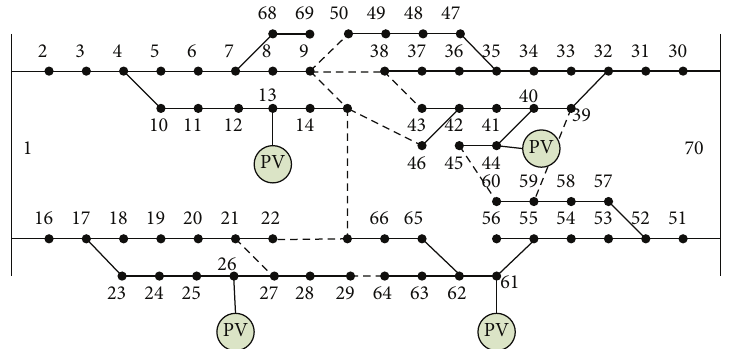
Figure 3: Optimal feeder reconfiguration obtained by chaos-based PSO and